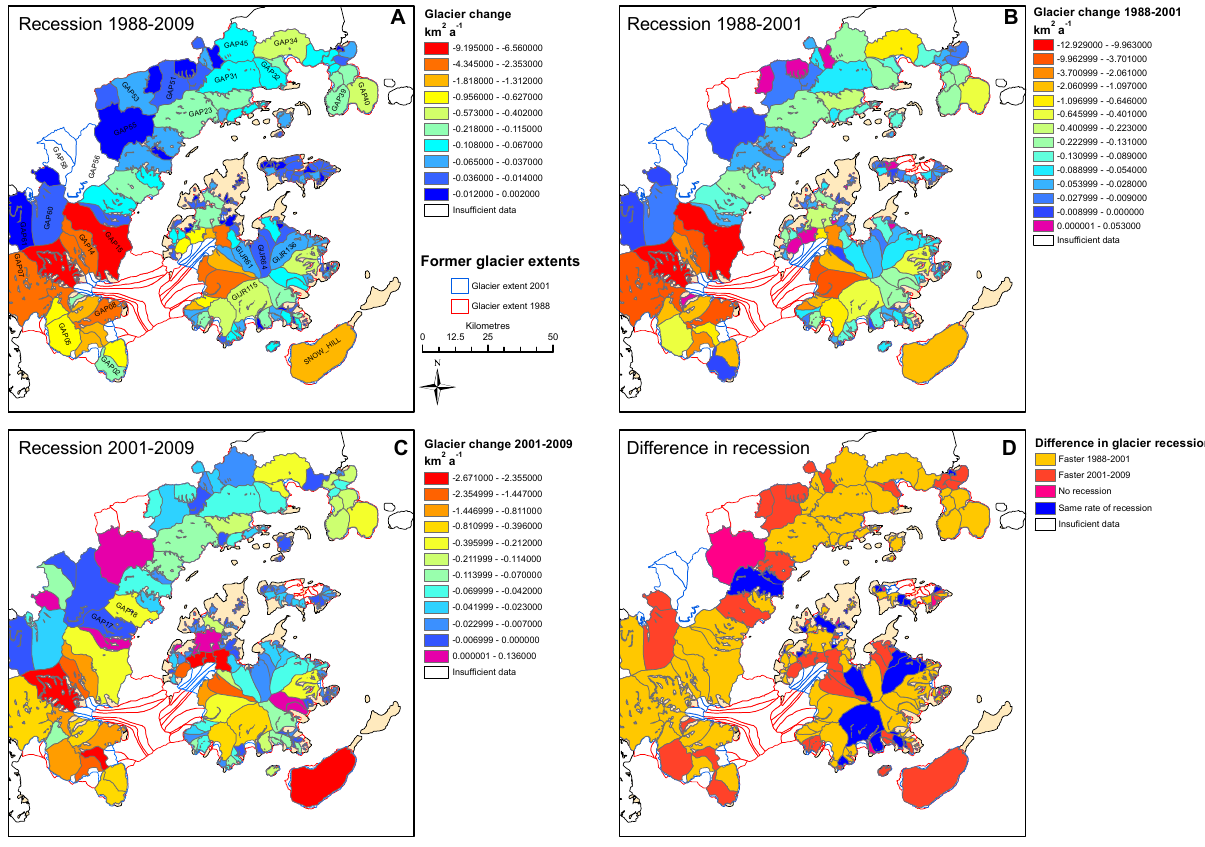
Fig. 7. Annual rates of shrinkage for different time periods. Glaciers in red shrank fastest. Glaciers in purple advanced. (A) Overall shrinkage, 1988–2009. Note the slow rates of shrinkage on western Trinity Peninsula. (B) Rates of shrinkage, 1988–2001. PGIS tributary glaciers shrank fastest. Note that two PGIS-tributary glaciers in R¨ohss Bay advanced during this period. (C) Rates of shrinkage, 2001–2009. Note a few small advancing glaciers. (D) Difference in shrinkage rates. Glaciers in blue shrank fastest between 1988 and 2001; glaciers in red shrank fastest after 2001. Note that PGIS tributary glaciers shrank slower after